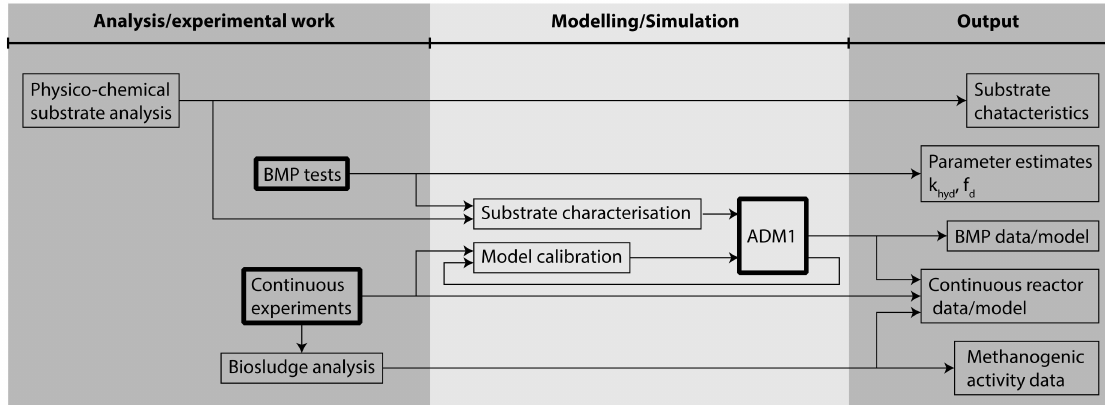
Figure 1. Work flow diagram describing the applied